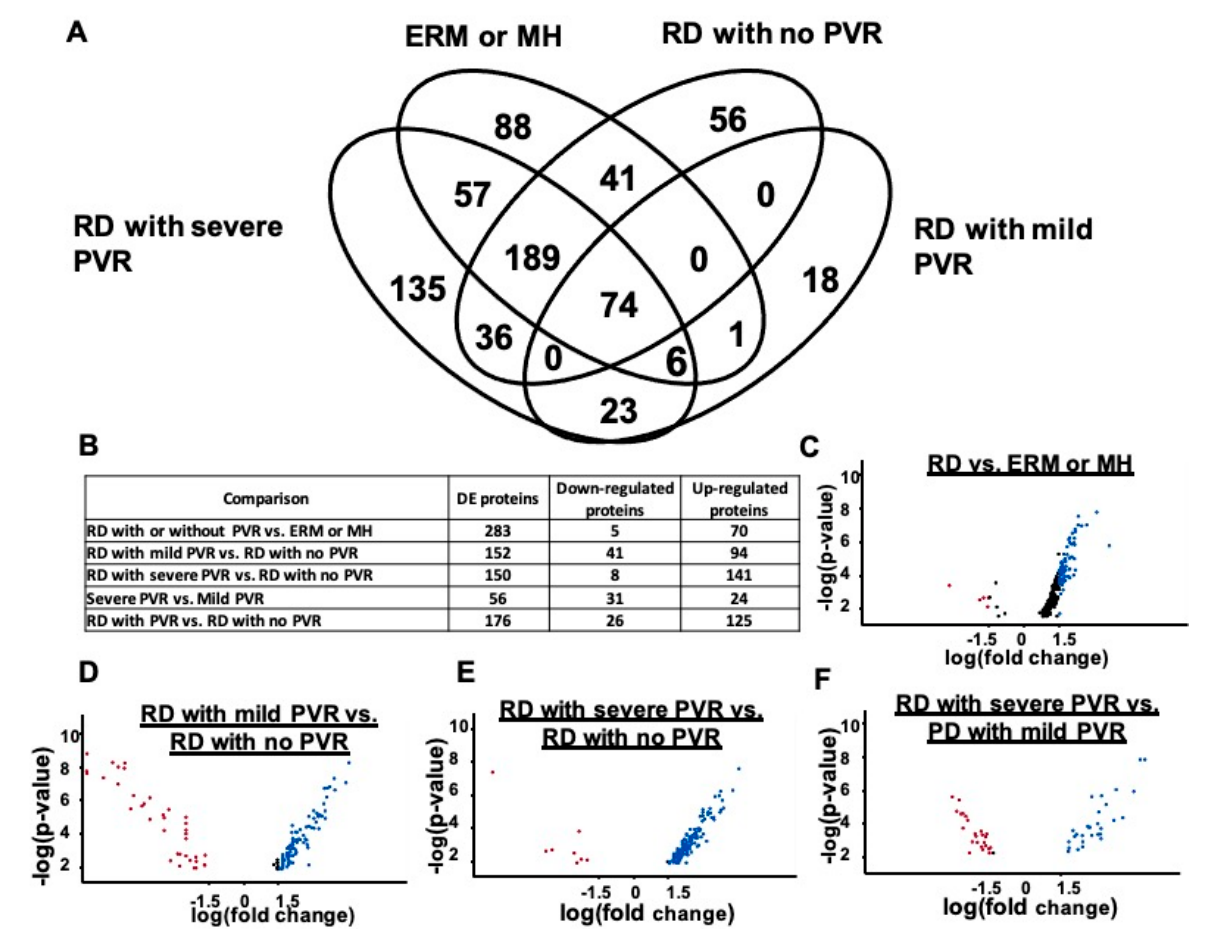
Figure 3. Proteomic analysis of exosome proteins from vitreous humor with PVR. ( A ) Venn diagram representing the total number of proteins identified ( n = 724). ( B ) Differentially expressed (DE) proteins in table and ( C – F ) in volcano plots with upregulated (blue dots) and downregulated (red dots) proteins.